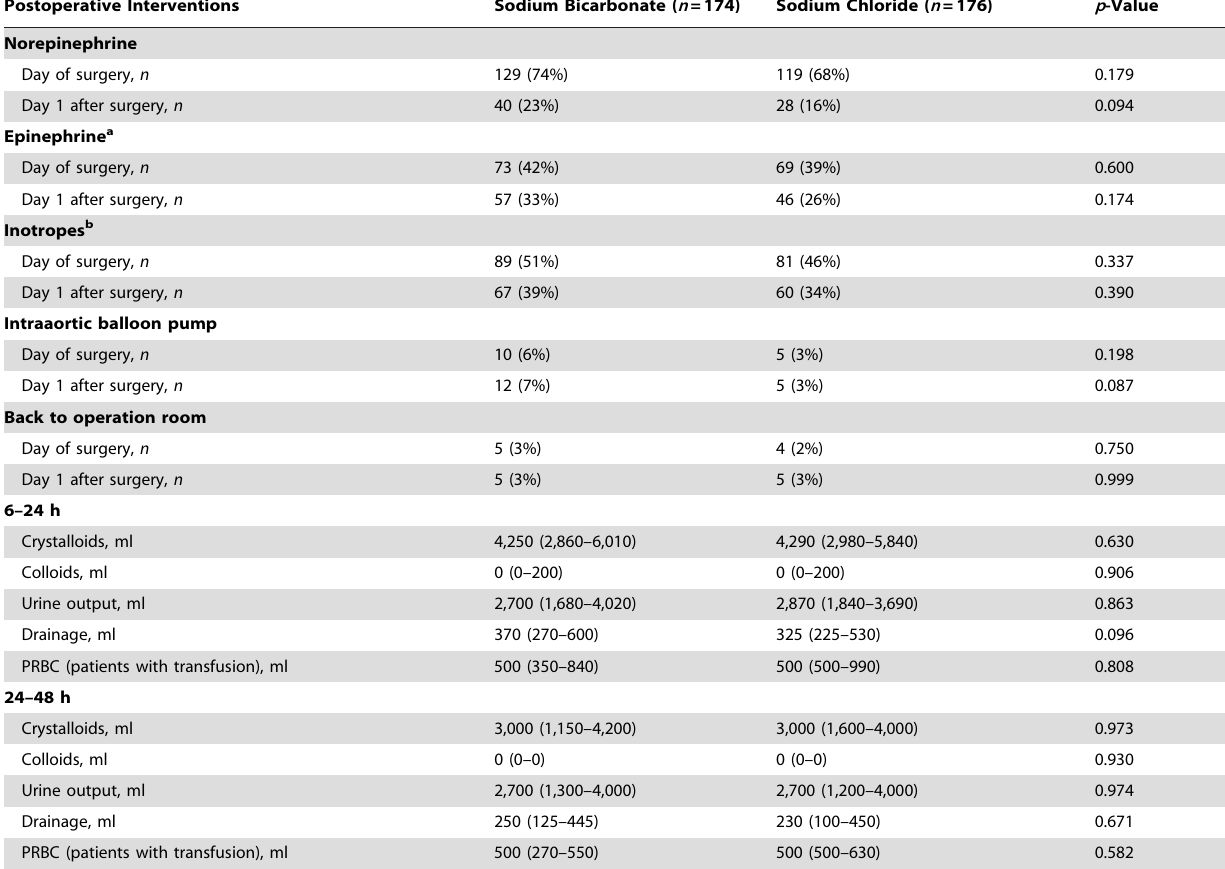
Table 5. Postoperative